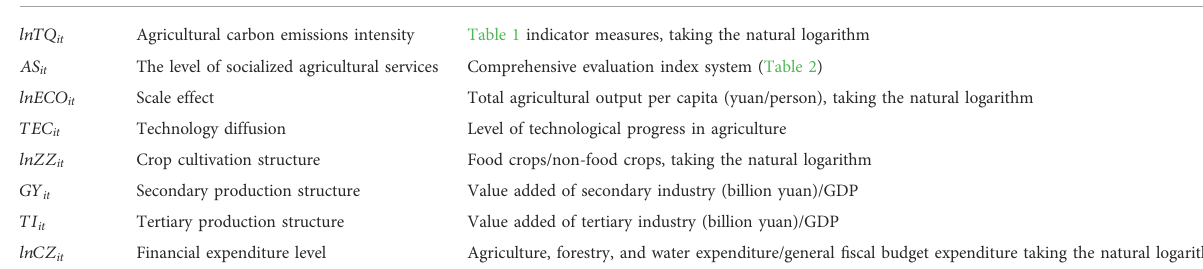
TABLE 3 Variable selection and de fi nition.